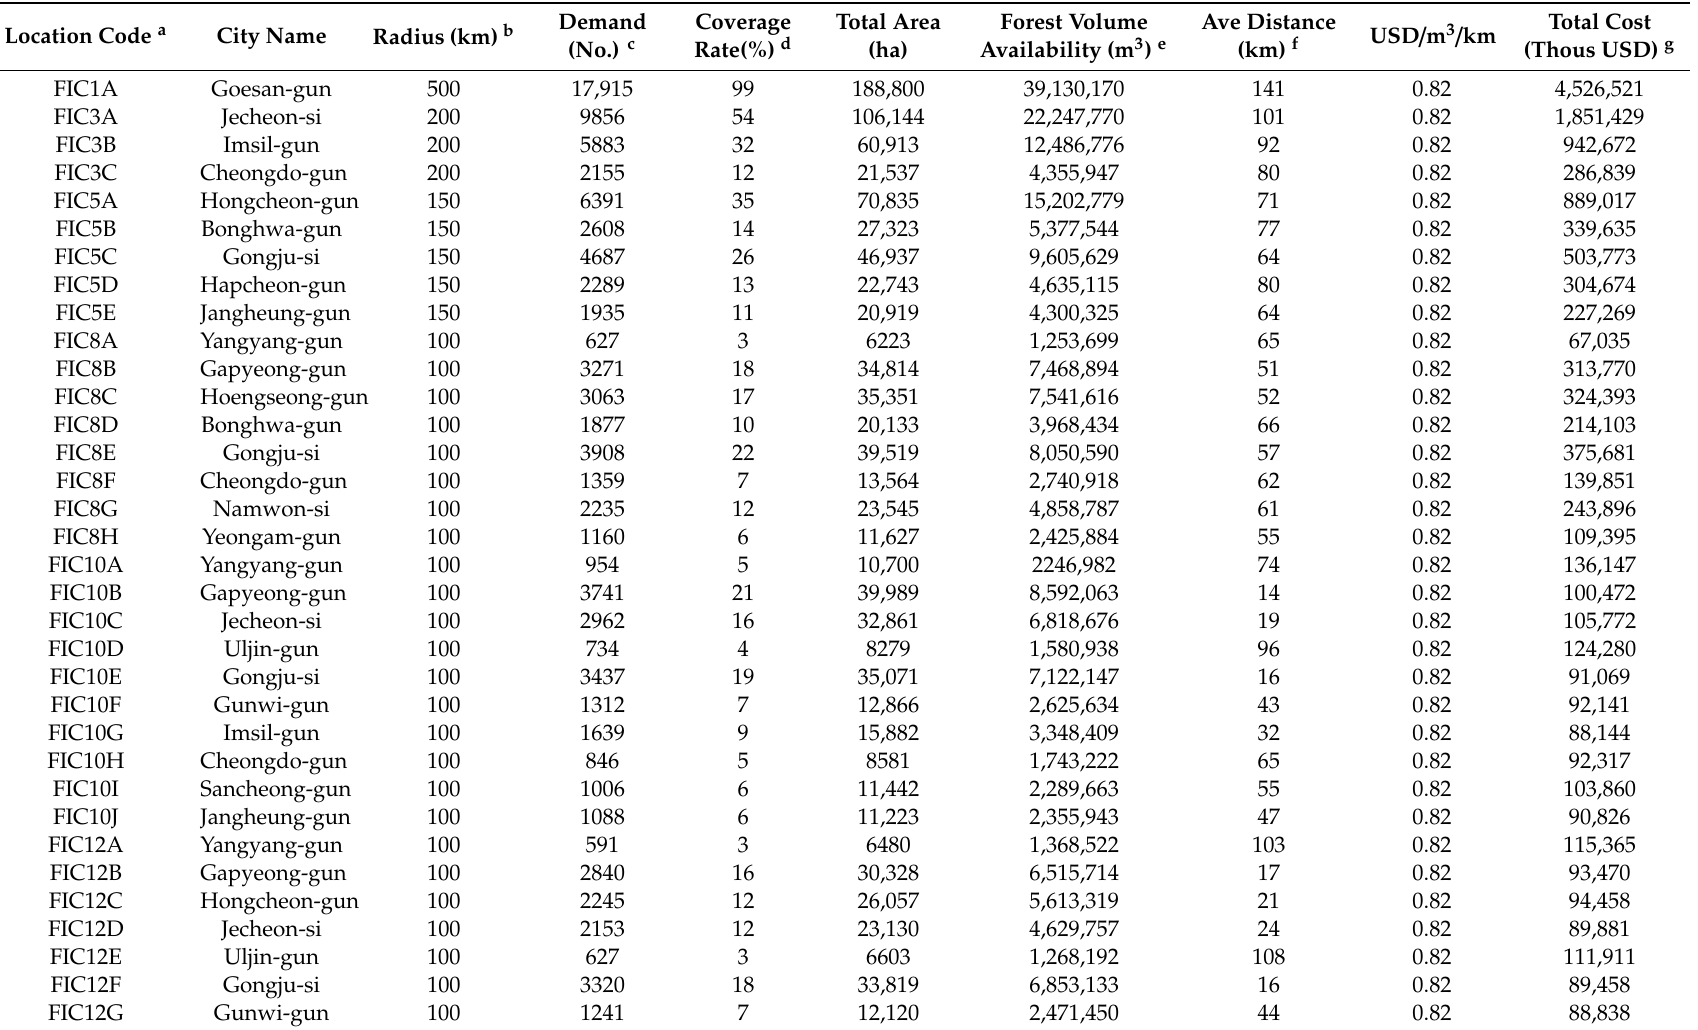
Table 7. Estimated transportation costs of forest resources depending on the number of FIC locations and their transportation limits. Location Code